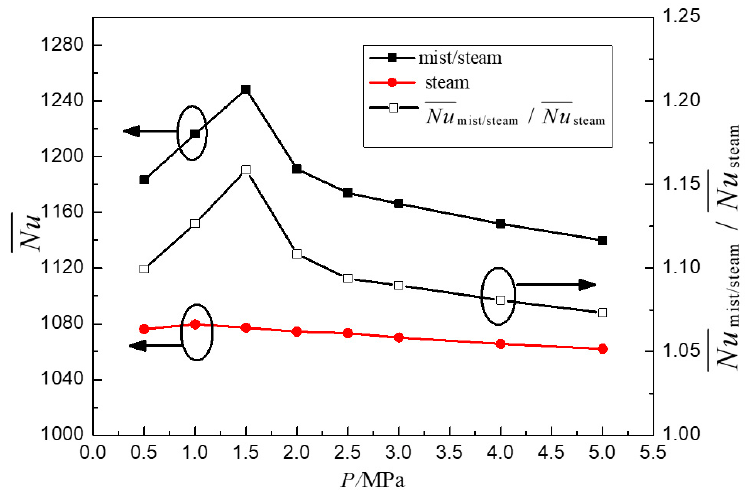
Figure 10. Variation in the average Nusselt number of the ribbed surface of mist/steam and steam cooling channels with the operating pressure.